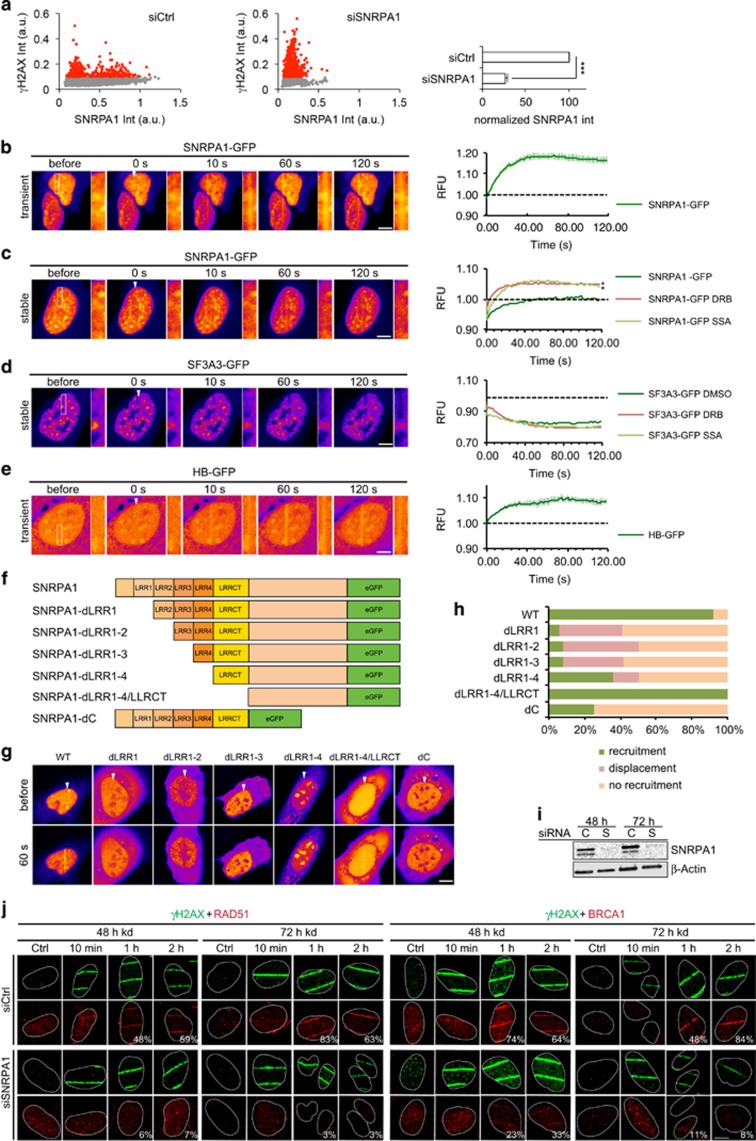
Recruitment kinetics of SNRPA1 and SF3A3 after laser microirradiation and SNRPA1-dependent recruitment of RAD51 and BRCA1 to laser tracks. (a) Image-based cytometry reveals increased γH2AX formation after 72 h SNRPA1 knockdown in U2OS cells. SNRPA1 knockdown effciency is shown in the bar graph. U2OS cells transiently (b) or stably (c) expressing SNRPA1-GFP were microirradiated and protein recruitment followed in real-time. For transcription and splicing inhibition cells were pretreated with DRB (50 μM) or SSA (100 nM) for at least 1 h before damage induction. Representative confocal images and recruitment kinetics are shown. (d) As in (b and c) but in cells stably expressing SF3A3-GFP. (e) Generation of R-loops at laser tracks visualized by HB-GFP recruitment. HB-GFP recruitment kinetics resemble SNRPA1-GFP. (f) Schematic of SNRPA1 deletion constructs. (g) Representative confocal images of recruitment of wild-type and mutated GFP-tagged SNRPA1 after laser microirradiation. (h) Quantification of recruitment, non-recruitment and displacement of GFP-tagged SNRPA1 fusions. Ten cells were analyzed per condition. (i) Confirmation of siRNA-mediated depletion of SNRPA1 after 48 and 72 h knockdown in cells used in (j). (j) Recruitment of RAD51 and BRCA1 in control and SNRPA1-depleted U2OS cells. U2OS cells were transfected with control or SNRPA1 siRNA and 48 or 72 h later microirradiated, fixed after indicated repair times and stained for γH2AX, RAD51 and BRCA1. Representative confocal images and percentage of cells displaying RAD51 and BRCA1 recruitment are shown. Scale bar 5 or 10 μM (i). Statistically significant differences were determined using Student's t-test, *P<0.05, **P<0.01. Error bars represent s.e.m. RFU (relative fluorescence units).